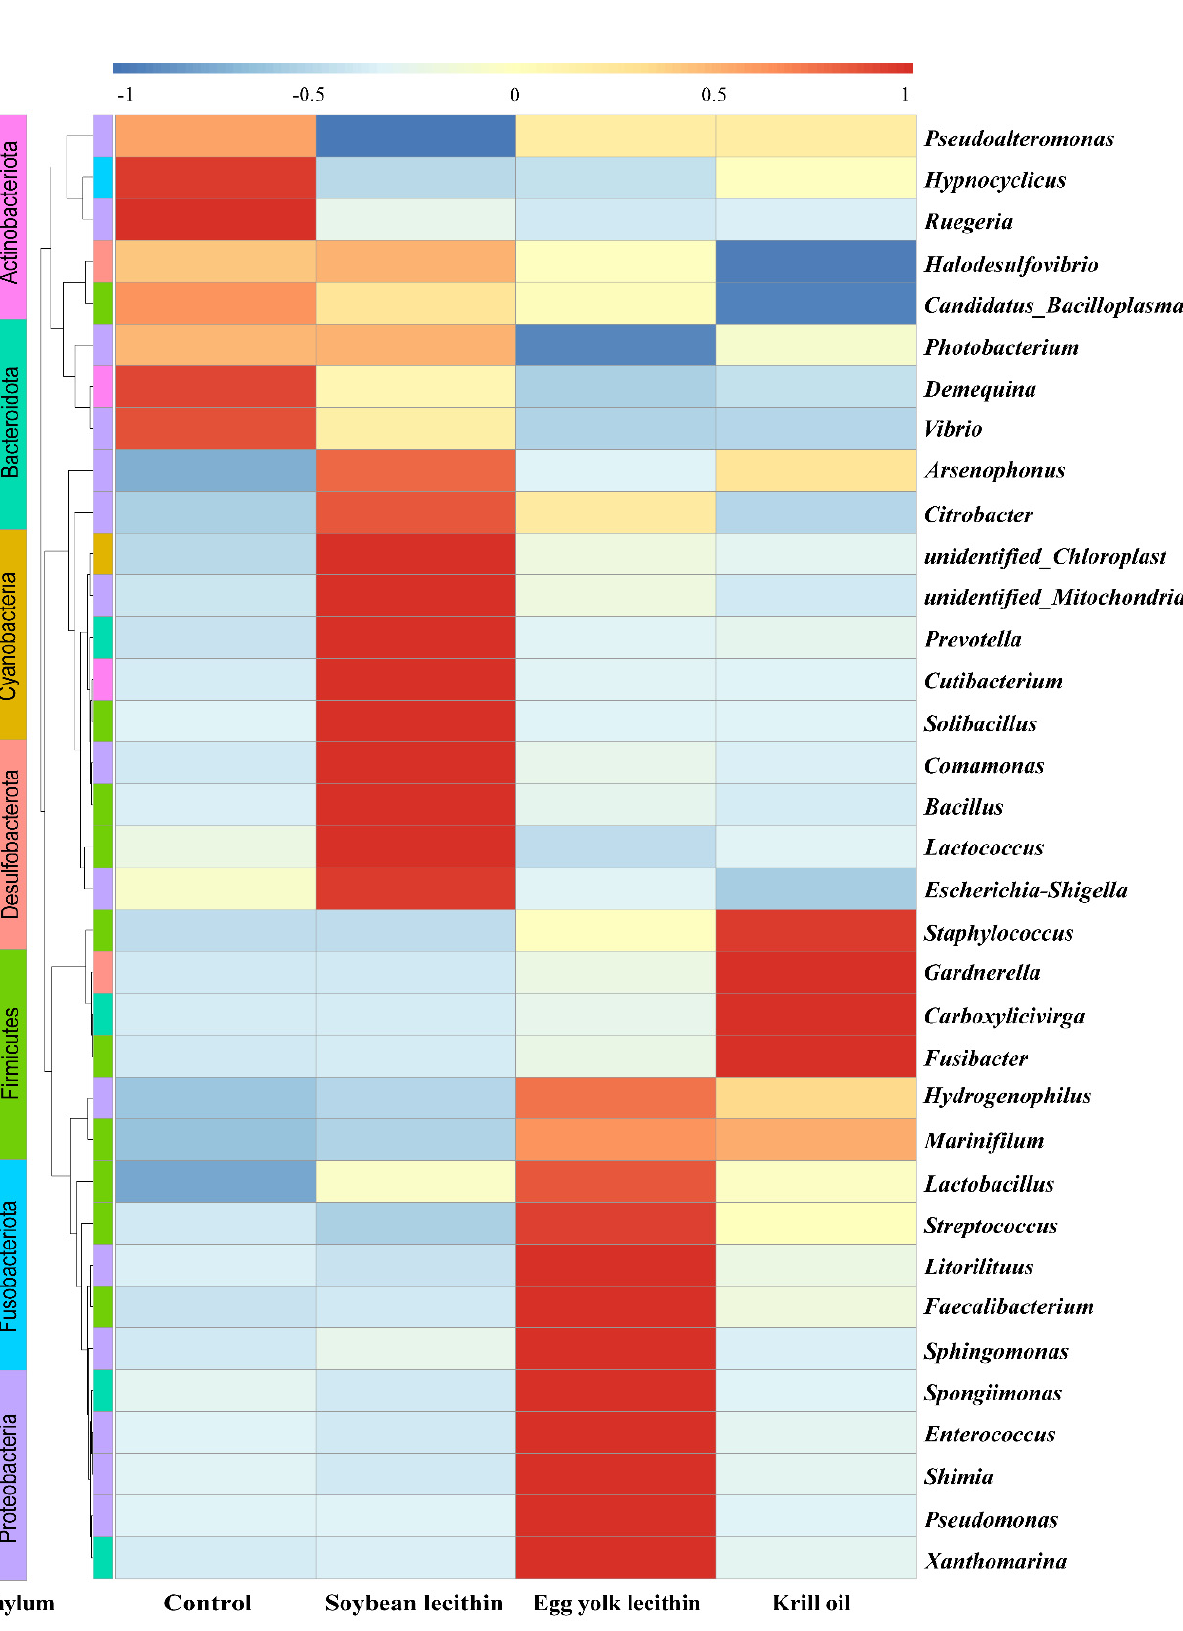
Figure 7. Genus-level composition (top 35) heat map of the gut microbiota of female L. vannamei fed different phospholipids. Warmer colors indicate a higher abundance of species.